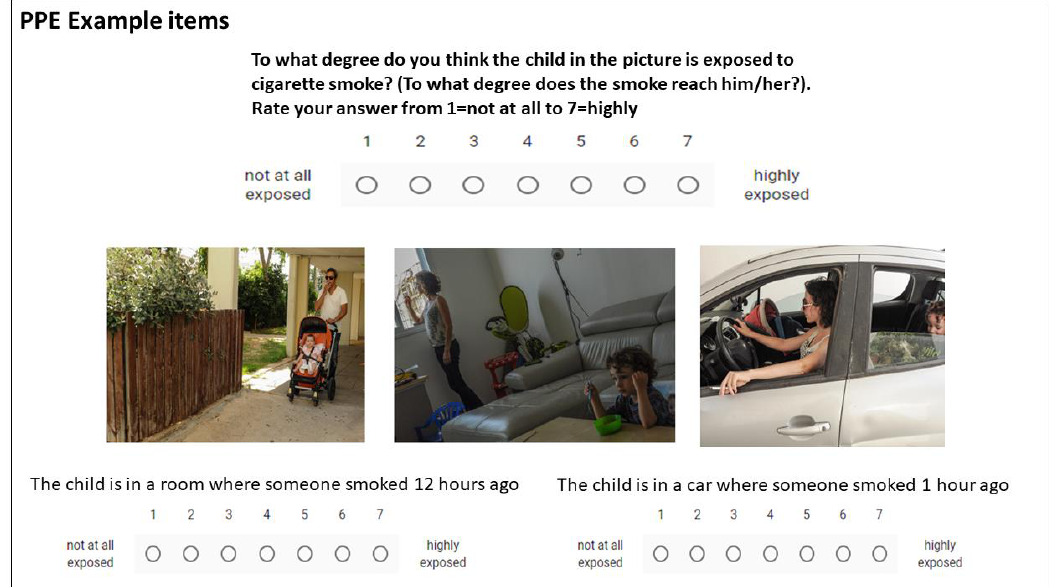
Figure 1. Example parental perceptions of exposure (PPE) items.